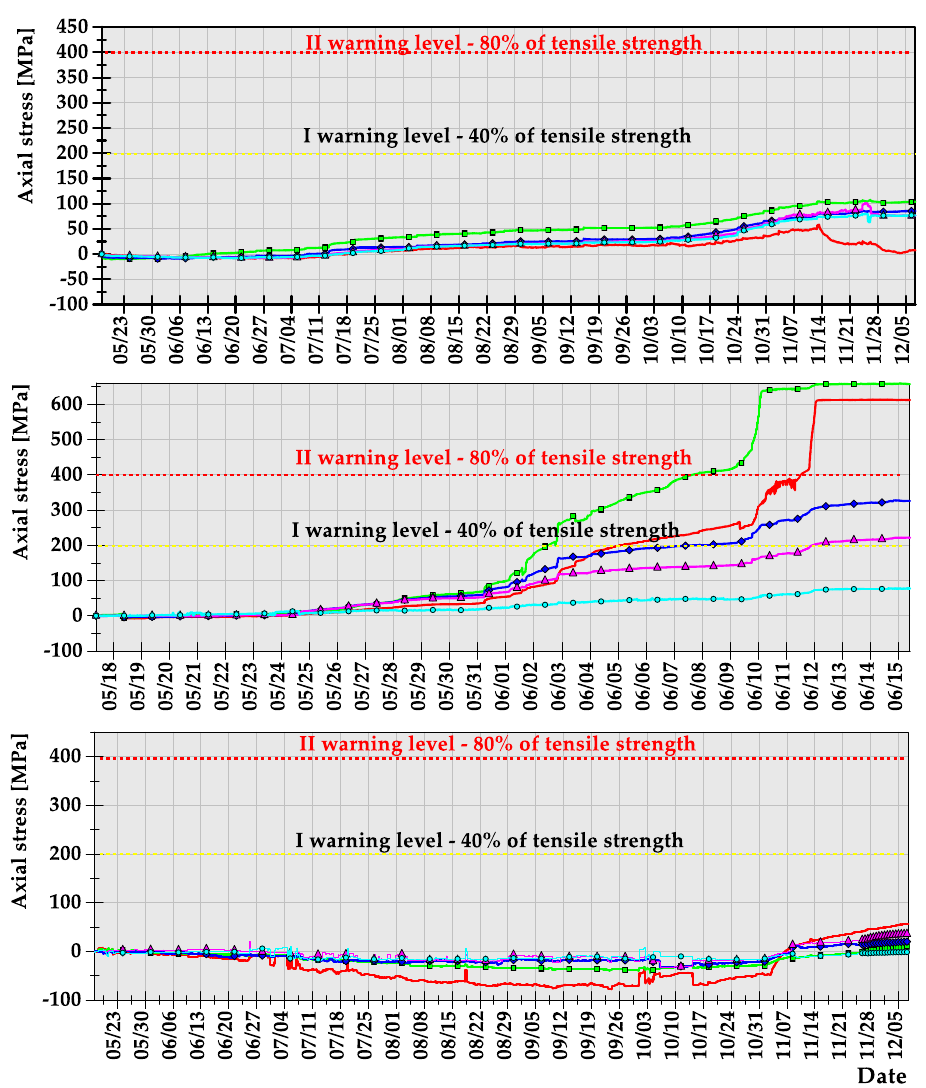
Figure 12. Axial stresses measured along rock bolts ’ bars during the underground measurement.